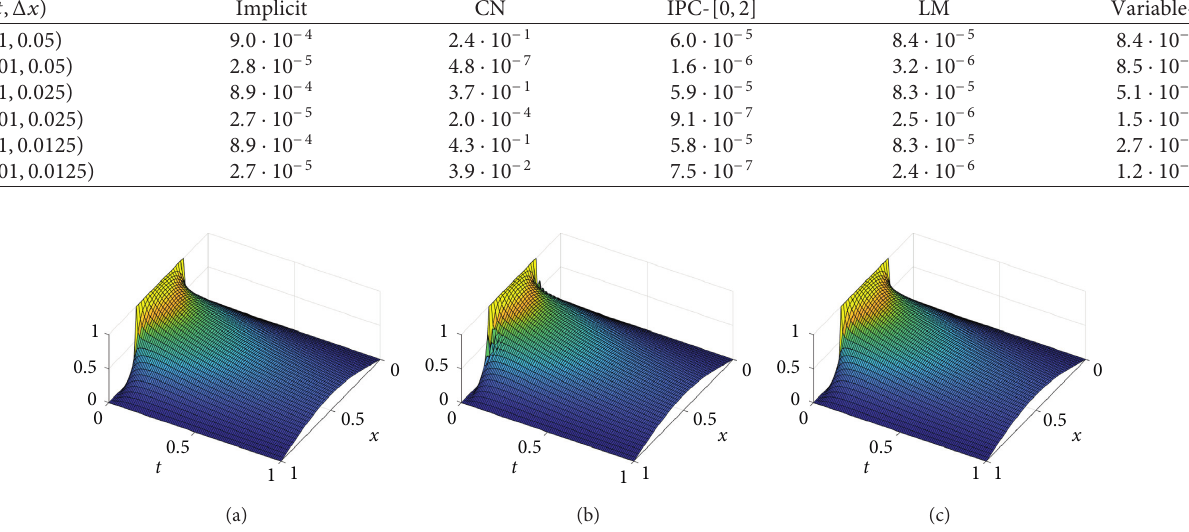
Figure 3: Propagation of the numerical solutions for (44): (a) the implicit method, (b) the CN method, and (c) the variable- θ method, for 0 ≤ t ≤ T � 1 . 0, when Δ t � 0 . 01 and Δ x � 0 .